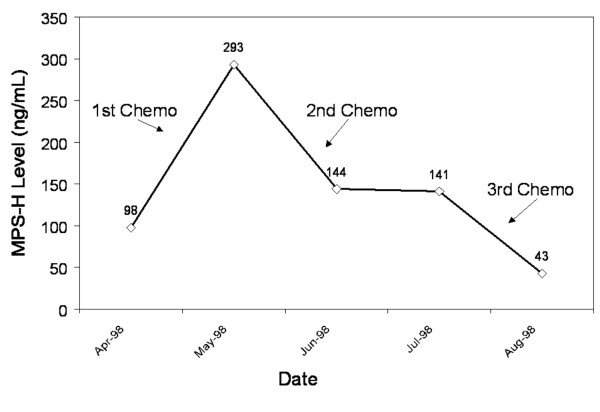
Patient with unresectable tumor. Note MPS-H level response to chemotherapy. Patient subsequently expired after refusing further therapy.